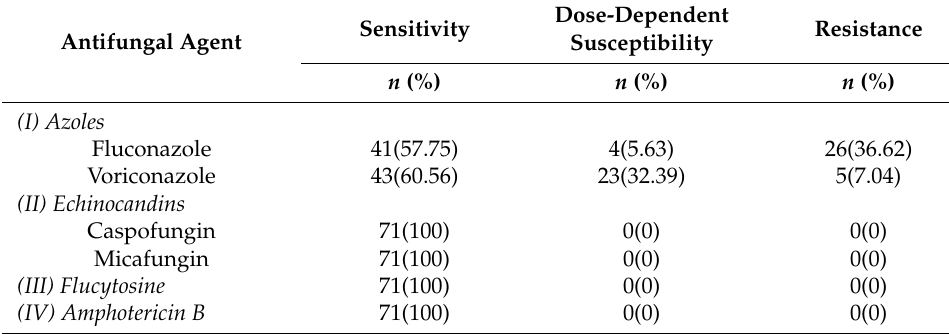
Table 1. Antifungal susceptibility profile of C. tropicalis clinical